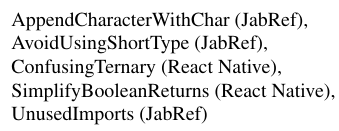
Fig. 3. Commonly-appearing violations which have NIPA > 0 in one